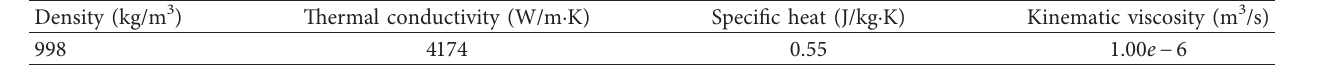
Table 3: Basic thermal physical parameters of water.